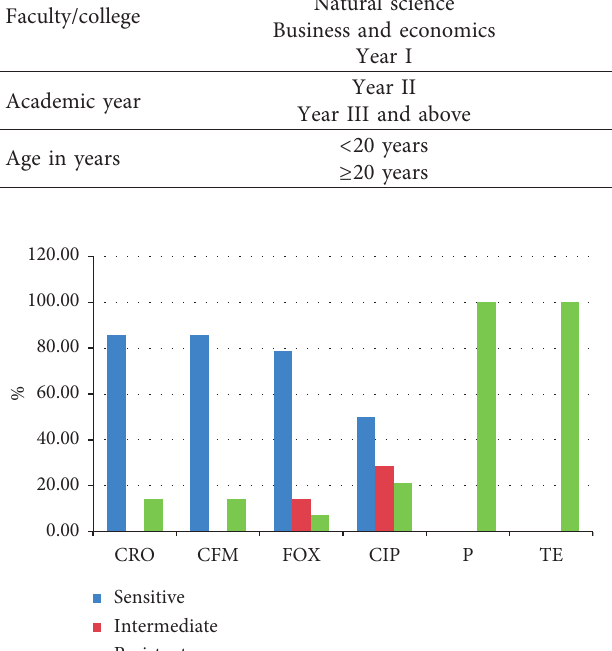
Figure 1: Antimicrobial susceptibility patterns of N. gonorrhoeae isolated from suspected university students for STI. P: penicillin; TE: tetracycline; CIP: ciprofloxacin; CRO: ceftriaxone; FOX: cefoxitin; CFM: